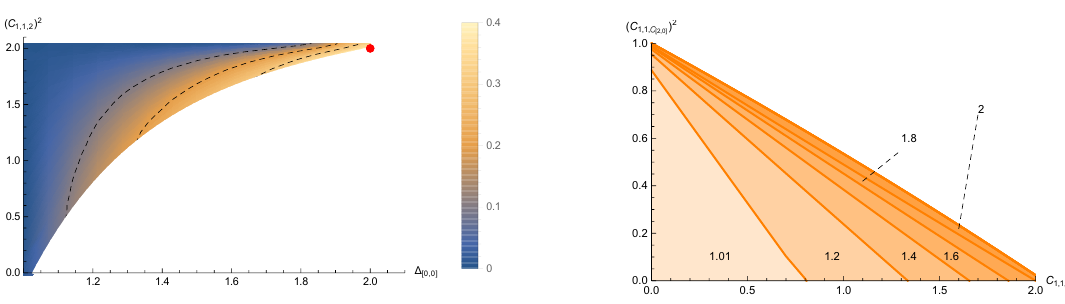
(cid:0) (cid:1) 2 Figure 8 . Left: upper bounds on the OPE coe(cid:14)cient C for given (cid:1) and of C 2 . (cid:1)[0 ; 0] [0 ; 0] 1 ; 1 ; 2 1 ; 1 ; L [0 ; 0] The numerics were done for (cid:3) = 80. The upper bound at the analytic solution for (cid:24) = 1, represented (cid:0) (cid:1) 2 by the red dot, is C (cid:20) 0 : 4. To our precision, the numerics exactly saturate the bound. 1 ; 1 ; L 2 [0 ; 0] The dashed lines show the levels 0 : 1, 0 : 2 and 0 : 3. Right: allowed region for the OPE coe(cid:14)cients C 2 and C 2 for a given value of (cid:1) 0 . Again, the numerics were done for (cid:3) = 80. The 1 ; 1 ; 2 1 ; 1 ; C [2 ; 0] [0 ; 0] upper bound does not change as (cid:1) 0 is varied and we denote the value (cid:1) 0 in black close to the [0 ; 0] [0 ; 0] lower bound. Note the region for a given (cid:1) 0 contains the regions for larger values of (cid:1) 0 . [0 ; 0] [0 ; 0]